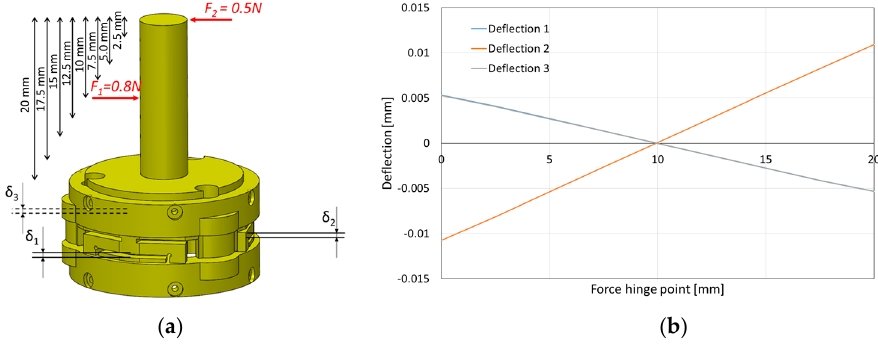
Figure 20. Effect of horizontal forces on the deflection of sensor beams. ( a ) Simulation of force application; ( b ) Deflections as a function of different amounts of applied moment (the resultant force is constant).